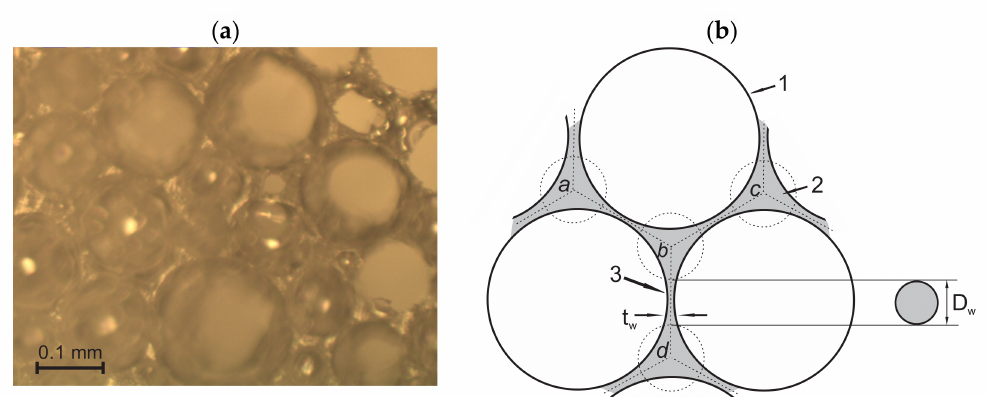
Figure 5. ( a ) Cutting surface of PU foams, ρ f = 224 kg/m 3 , a wedge-shaped slice, with the inner side of the cut bubbles visible and ( b ) a scheme of cross-sections of 1—a bubble, 2—a strut (Transversal cross-section), and 3—a wall (t w —thickness and D w —diameter of the front view). Image plane X 1 =